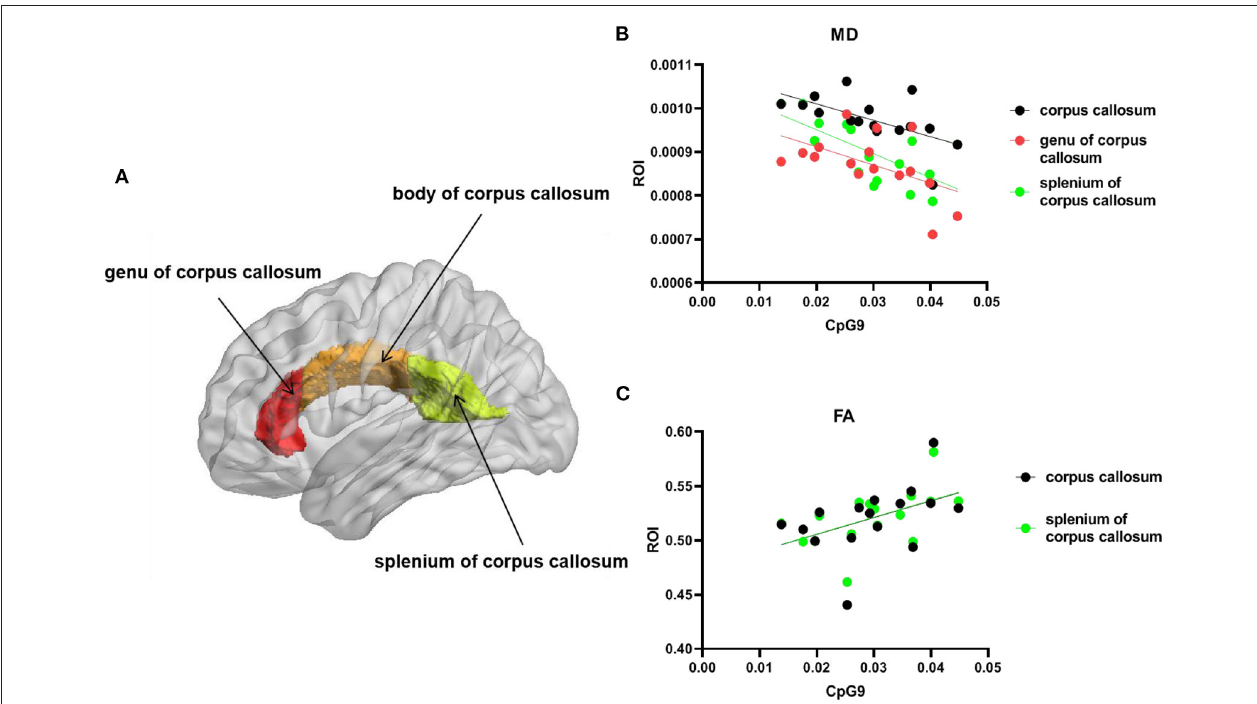
FIGURE 3 | Scatter plot and line show the association between the degree of CpG9 methylation and the fractional anisotropy (FA) and mean diffusivity (MD) values in the region of interest (ROI) of the brain. (A) ROI: the total corpus callosum (CC). Red represents the genu, orange represents the body, and green represents the splenium of the CC. The statistical threshold for the contrasts was p < 0.05. (B) Black circles and line represent the MD values of the whole CC, the red circles and line represent the MD values of the genu of the CC, and the green circles and line represent the MD values of the splenium of the CC. (C) Black circles and line represent the FA values of the whole CC and the green circles and line represent the FA values of the splenium of the CC.